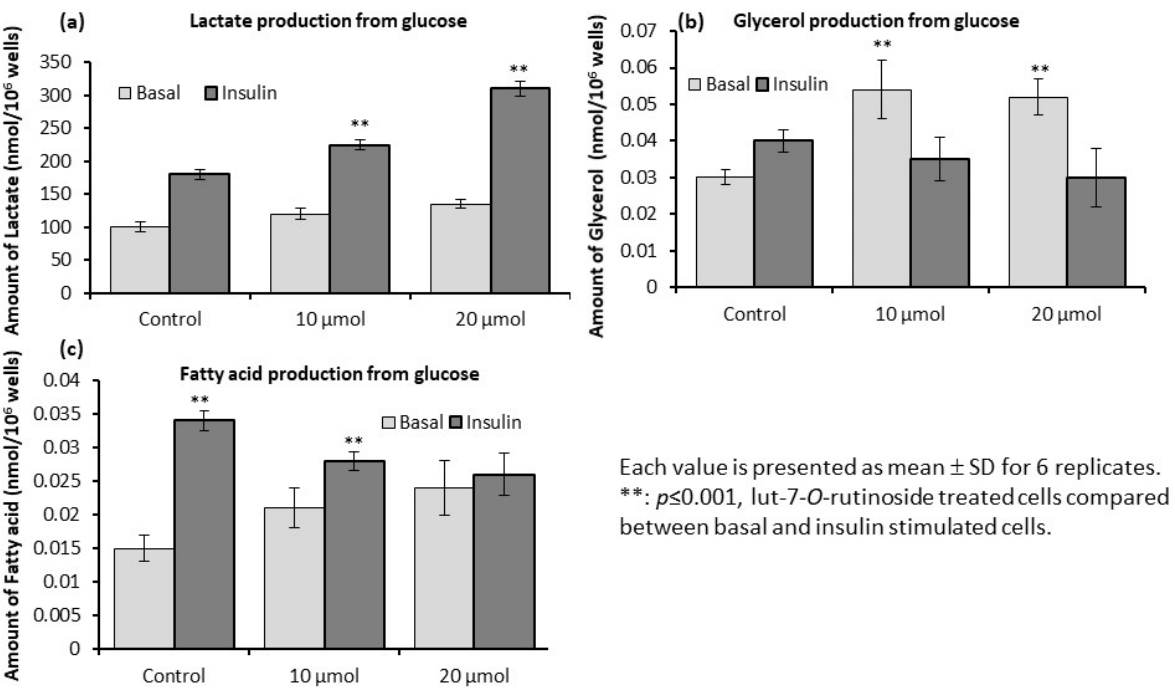
Figure 5. Effect of lut ‐ 7 ‐ O ‐ rutinoside on intracellular production of lactate ( a ), glycerol ( b ), and fatty acids ( c ) from glucose in basal and insulin ‐ stimulated conditions in L6 myotubes. Each value is presented as the mean ± SD for 6 replicates. **: p ≤ 0.001, lut ‐ 7 ‐ O ‐ rutinoside ‐ treated cells compared to basal and insulin ‐ stimulated cells.